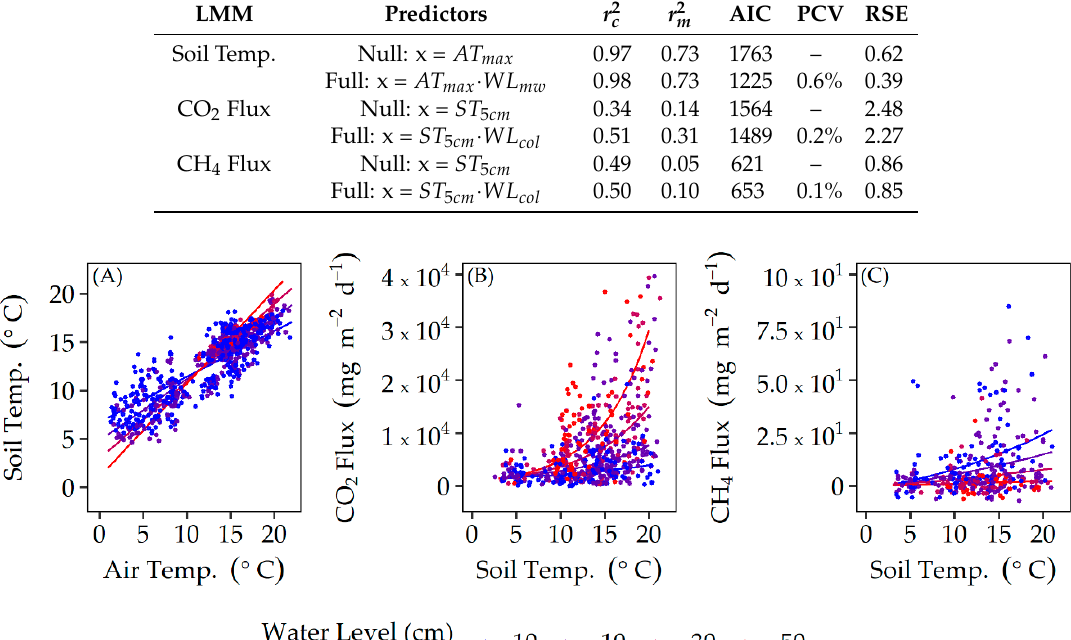
Table 1. Model evaluation statistics for soil temperature, CO 2 flux, and CH 4 flux linear mixed models (LMMs; Figure 2). Residual standard error (RSE) was reported for soil temperature for soil CO 2 and